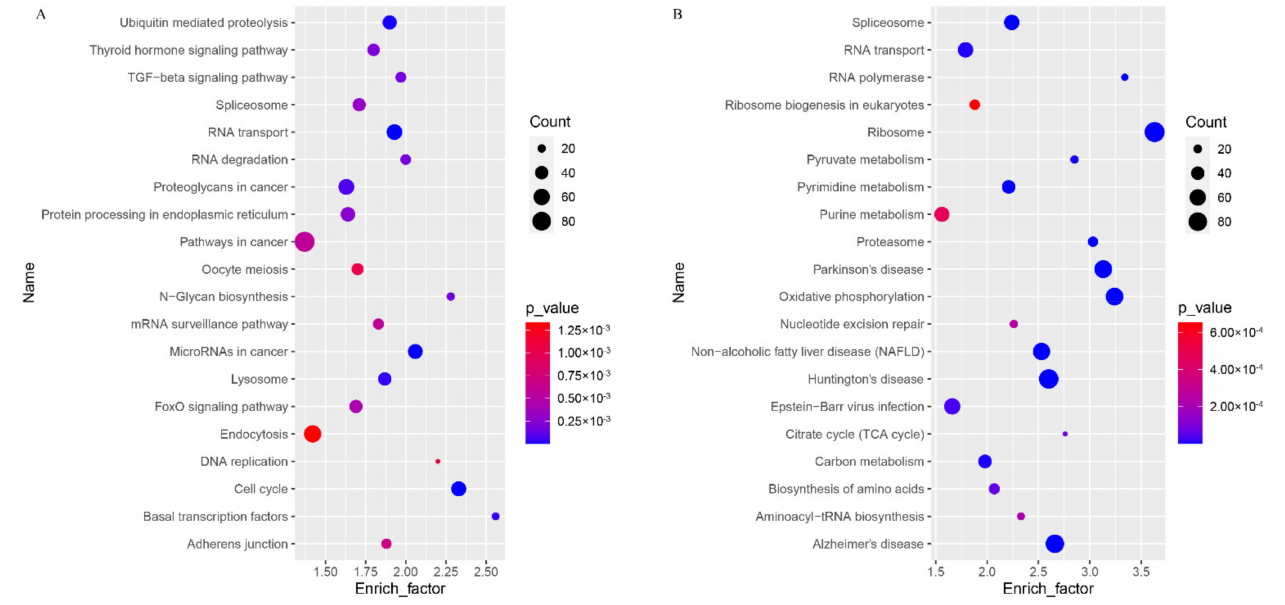
Figure 4. KEGG enrichment of the top 20 ( A ) up-regulated and ( B ) down-regulated terms.